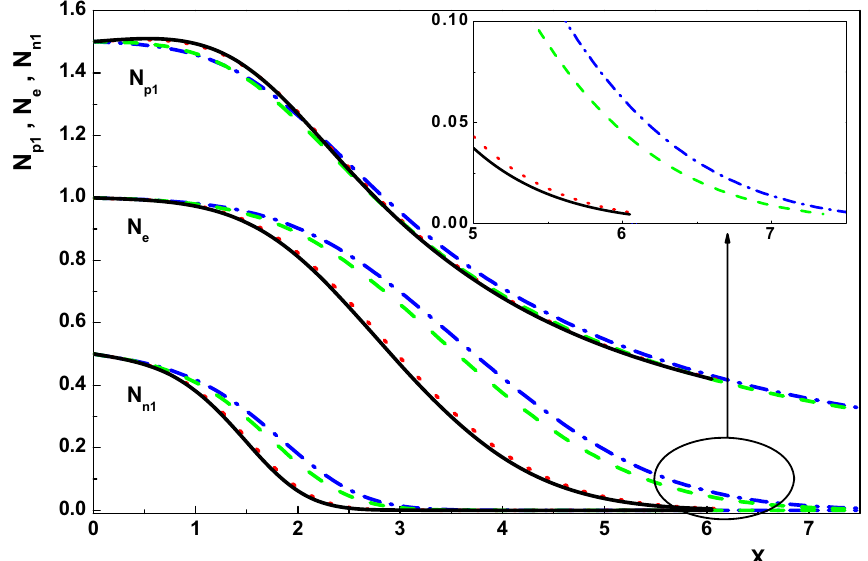
Figure 5. Variation of the normalized density distribution of the charged particles toward the wall for ν p 1 = 0, u 01 x = 0.720, α = 0.01 (dotted line), ν p 1 = 0, u 01 x = 0.933, α = 0.02 (dotted-dashed line), ν p 1 = 0.005, u 01 x = 0.721, α = 0.01 (solid line) and ν p 1 = 0.005, u 01 x = 0.935, α = 0.02 (dashed